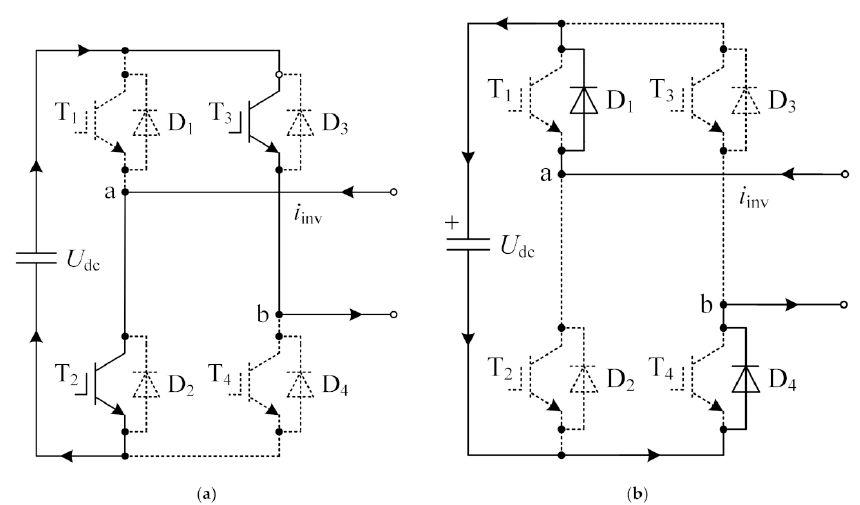
Figure 5. Schematic diagram of the converter when i inv < 0: ( a ) The configuration and channel current of the grid-connected converter when T 2 and T 3 are on; ( b ) The configuration and channel current of the grid-connected converter when D 1 and D 4 are